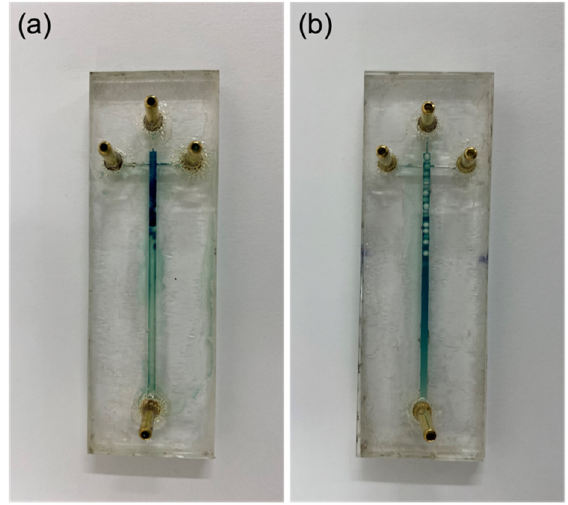
Figure 4. Immobilized laccase activity test. Microreactors with ( a ) Laccase ‐ alginate microcapsules and ( b ) Laccase ‐ Al 2 O 3 pellets showing catalytic activity in a ABTS assay.